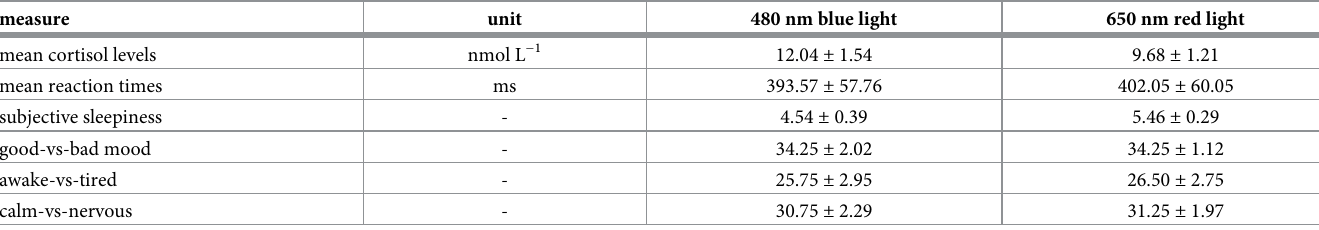
Table 2. Mean ± SEM results of the various physiological and subjective outcome